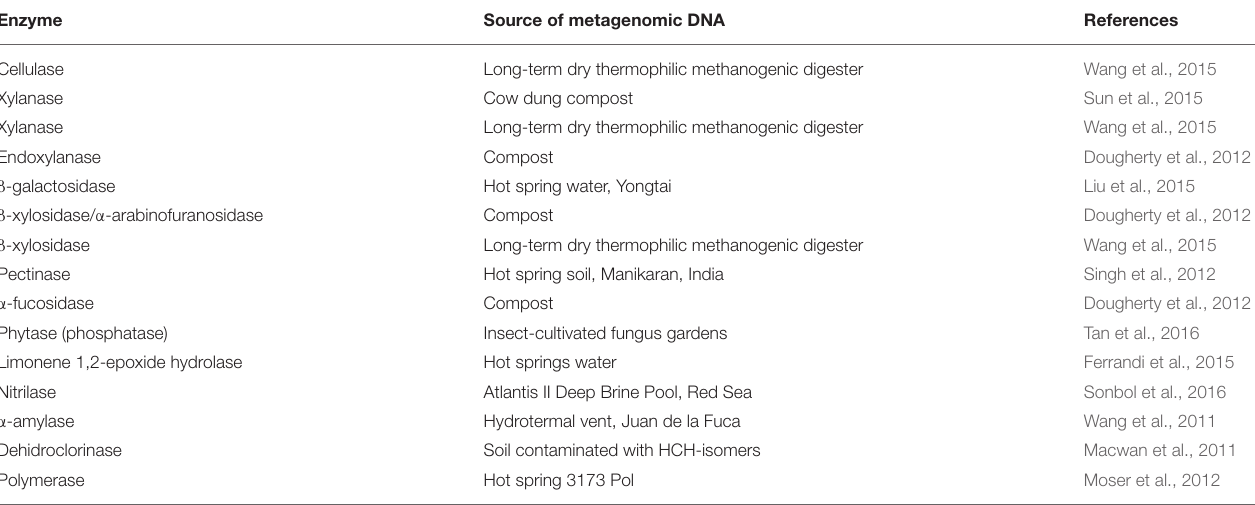
TABLE 4 | Examples of thermozymes isolated by sequence-based screening of